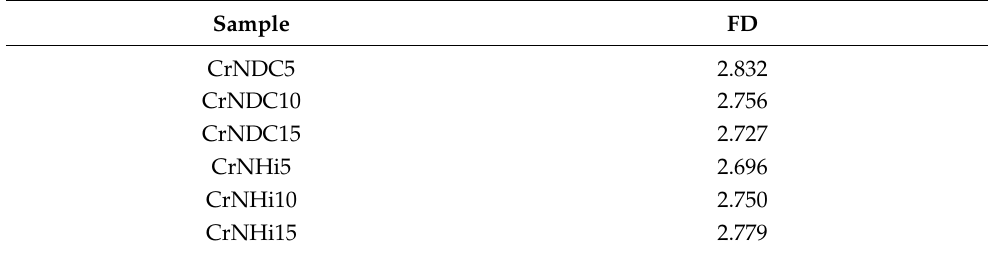
Table 2. Fractal dimension (FD) measurements of surface morphology for each sample.